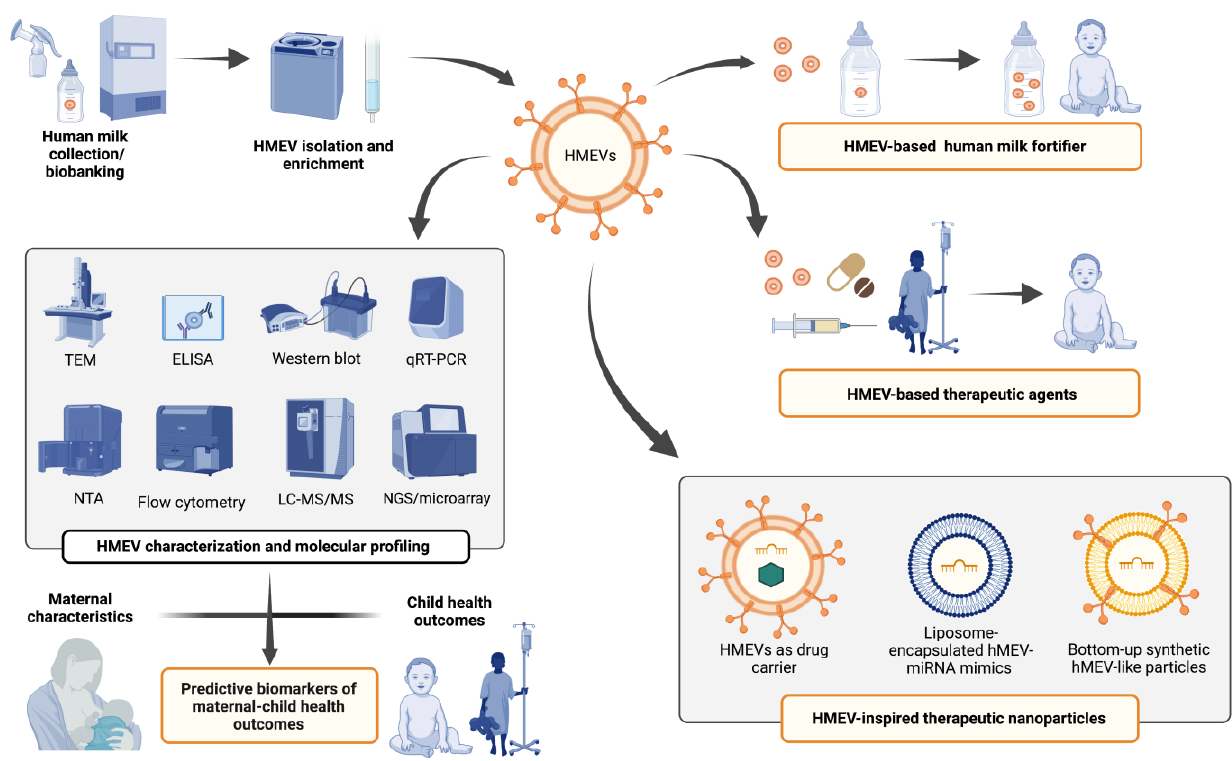
Figure 3. Potential clinical applications of hMEVs as predictive biomarkers of maternal–child health outcomes and as a source or inspiration for novel nutraceuticals/therapeutics. Abbreviations: TEM, transmission electron microscopy, ELISA, enzyme-linked immunosorbent assay; qRT-PCR, quantita- tive real-time polymerase chain reaction; NTA, nanoparticle tracking analysis; LC-MS/MS, liquid chromatography-tandem mass spectrometry; NGS, next-generation sequencing; EV, extracellular vesicles; HMEV, human milk derived extracellular vesicles.